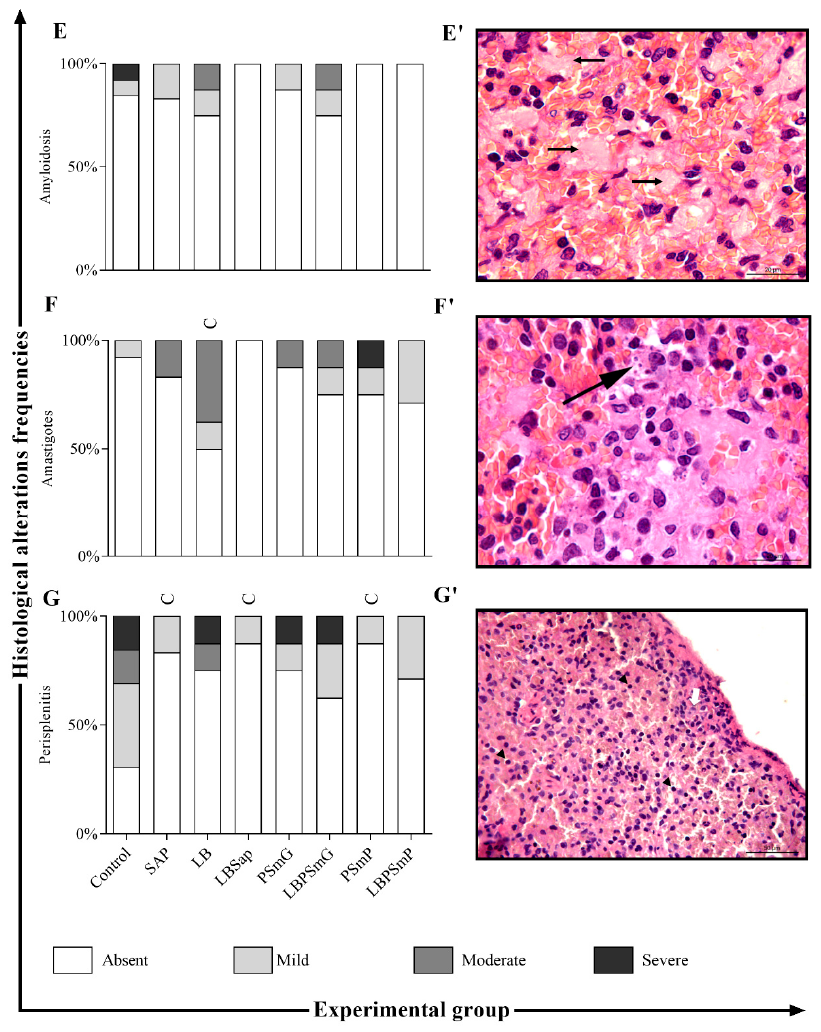
Figure 3. Histological changes in the spleen after L. infantum experimental challenge in slides stained by Hematoxylin and Eosin. On the left: The x axis represents the frequency of each histo- logical change ( A – G ) according to the immunization group (Control—C, Sap, LB, LBSap, PSmG, LBPSmG, PSmP, and LBPSmP) shown in the y axis. On the right: The photomicrographs refer to the main histological changes found in hamster spleens after experimental challenge. ( A (cid:48) )—Lymphohistiocytic and neutrophilic inflammatory infiltrate (red pulp) (head arrows): inflammatory histiocytic inflammatory with some neutrophils (white arrows), multifocal, moderate (40 × magnifi- cation); ( B (cid:48) )—Lymphohistiocytic and neutrophilic inflammatory infiltrate (white pulp): moderate multifocal inflammatory infiltrate (black arrow) (100 × magnification); ( C (cid:48) )—Lymphoid hyperplasia: discrete multifocal lymphoid hyperplasia associated with moderate diffuse hyperemia (20 × magnifi- cation) (circled areas); ( D (cid:48) )—Granuloma: inflammatory histiocytic infiltrate, with some lymphocytes (head arrows) and plasmacytes (white arrow) and rare multinucleated giant cells, forming micro- granulomas, multifocal to coalescent, intense, associated with the deposition of eosinophilic (black arrows), amorphous and acellular material in red pulp, compatible with amyloidosis, diffuse and moderate (40 × magnification); ( E (cid:48) )—Amyloidosis: deposition of mild eosinophilic, amorphous and acellular material in the red pulp (black arrows), compatible with intense diffuse amyloidosis (100 × magnification); ( F (cid:48) )—Amastigotes: microgranulomas containing intracytoplasmic Leishmania infan- tum amastigotes (black arrow) in histiocytes (increase of 100 × ); ( G (cid:48) )- Perisplenitis: discrete multifocal lymphohistiocytic perisplenitis (lymphocytes—head arrows; and histiocytes—white arrows) (40 × magnification). Statistical differences ( p < 0.05, Mann–Whitney) between groups are indicated by acronyms in the correlated